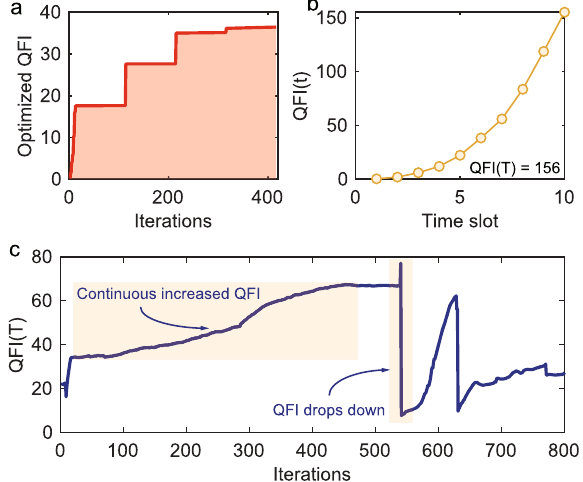
Fig. 6 The GRAPE algorithm for optimizing quantum control pulses (box shape) in time-dependent parameter estimation. a denotes the optimized QFI curve in each iteration, ( b ) shows the cumulated QFI varied with the time slot. ( a ) and ( b ) display the simulation results of the fi rst implementation of GRAPE algorithm. c represents the fi nal time QFI varied with the optimization iterations. Simulation parameters: A = 1, ω = 1, T = 5, δ t = 0.5, Δ t = 0.05, ϵ = 10 − 4 for ( a , b ), A = 1, ω = 1, T = 5, Δ t = 0.25, ϵ = 10 − 4 for ( c ).